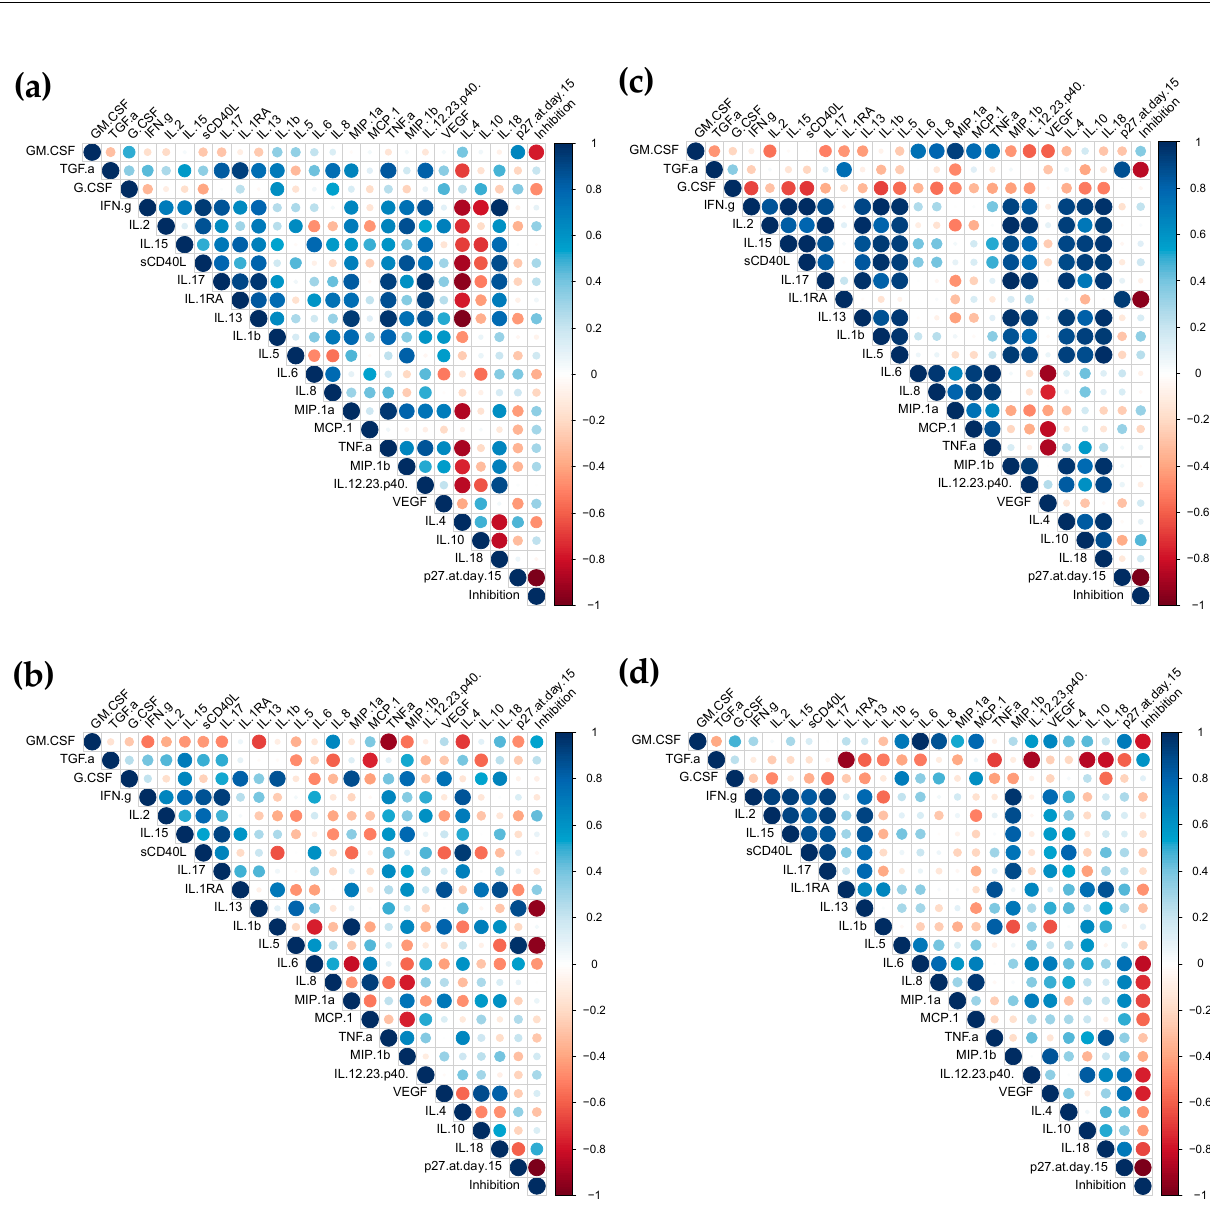
Figure 5. Correlogram of the vaccine responses elicited in mucosal explants. The correlations between the levels of secreted cytokines and susceptibility to ex vivo challenge with SHIV BaL ([p27] (pg/mL) at day 15 and % of inhibition) in cervical ( a , c ) and rectal explants ( b , d ) at week 26 ( a , b ) or week 6 ( c , d ) were analyzed by a correlation matrix. Positive Pearson correlation coefficients are displayed in blue and negative correlations are displayed in red. The color intensity indicated in the side bar is proportional to the correlation coefficient. The size of the circle is proportional to the statistical significance of the correlation. Statistical significance from p ≤ 0.05.